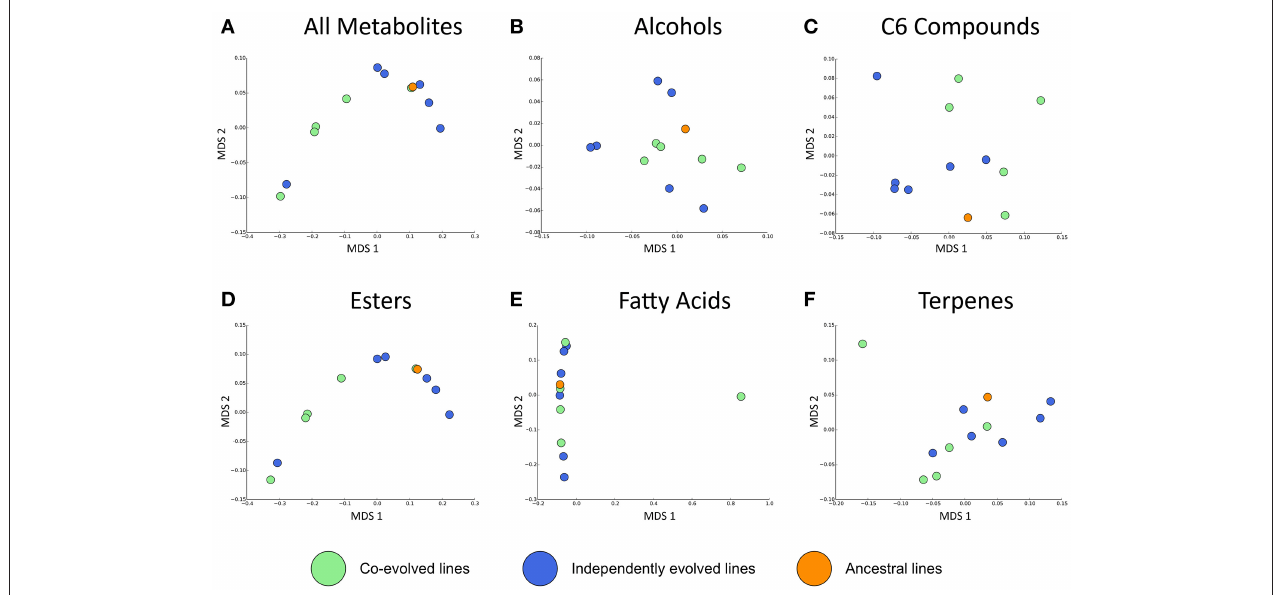
FIGURE 4 | Jaccard dissimilarities of metabolite profiles—averaged across technical replicates—for (A) All metabolites, (B) Higher alcohols, (C) C6 compounds, (D) Esters, (E) Fatty acids, (F) Terpenes in Juice A.